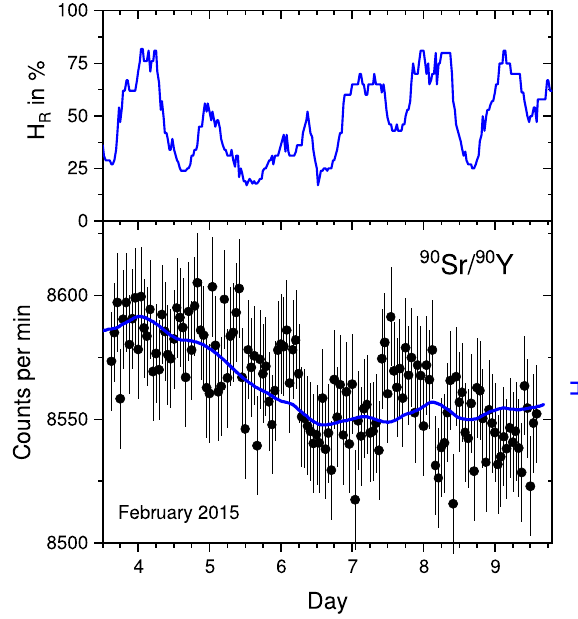
Fig. 3 Relative humidity in the Valencia region (top) in the period 22– 27 Apr 2015 [68]. Qualitative comparison (bottom) of measured 226 Ra decay rates [27,29] with the accumulated-humidity model H C ( t ; ¯ H R = 66% ,(cid:3) t = − 7h ) in Eq. 1